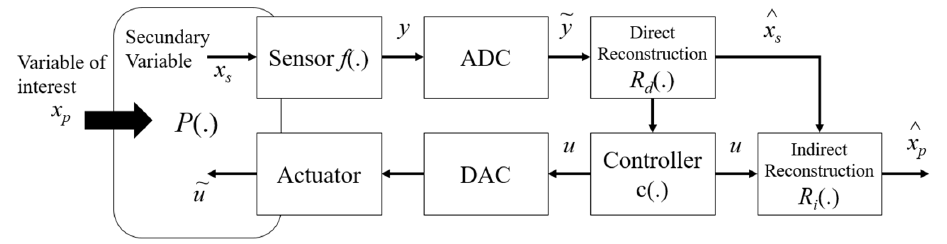
Figure 1. Generic diagram of a measurement feedback system adapted from [16]. Using sensors to acquire input variables, the secondary variable 𝑥 (cid:3046) is acquired and converted into an electrical signal 𝑦 using the sensor function 𝑓(cid:4666) . (cid:4667) . Then, this signal is converted to a digital signal through an AD inverter providing a signal 𝑦(cid:3556) , which is used to estimate the secondary quantity 𝑥 (cid:3046) , using the reconstruction function 𝑅 (cid:3031) . This last relationship corresponds to the inverse function of the sensor implemented in a discrete system. The signal 𝑥(cid:3548) (cid:3043) corresponds to the reconstruction of the signal coming from the input but indirectly from the controller 𝑐(cid:4666) . (cid:4667) and the direct reconstruction 𝑅 (cid:3031) (cid:4666) . (cid:4667) . Equation (1) describes the conversion factor to obtain the 𝑥 (cid:3046) signal [7]. 𝑥 (cid:3404) 𝑅 (cid:4666)𝑦(cid:4667) (cid:3404) 𝑓 (cid:2879)(cid:2869) (cid:4666)𝑦(cid:4667) (1) (cid:3046) (cid:3031) The DA inverter and the actuators present are responsible for controlling the secondary variable 𝑥 𝑠 at a certain reference value (setpoint). For this, the controller uses the measured values of the secondary variable together with the setpoint value, generating a discrete signal ( 𝑢 ) . This signal is converted into an analog signal (through a D/A inverter) and then through an actuator; this converted signal is applied to the 𝑃(cid:4666) . (cid:4667) plant. Thus, after these procedures, the main variable is estimated in the indirect reconstruction block 𝑅 (cid:3036) (cid:4666) . (cid:4667) , using the values of the control signal. Equation (2) represents this estimation. 𝑥 (cid:3043) (cid:3404) 𝑅 (cid:3036) (cid:4666)𝑥 (cid:3046) , 𝑢(cid:4667) (2) The actuation signal modifies the dynamics of the plant 𝑃(cid:4666) . (cid:4667) so that the response of the secondary signal 𝑥 𝑠 follows the setpoint value; therefore, it will modify the dynamics in the estimation of the main variable 𝑥 𝑝 . The convergence speed of this estimate will depend on how the controller is designed. 3.3. Adaptive Control In today’s language, the term adapt means to modify behavior according to new circumstances or situations. In the engineering context, adaptive control can be defined as a control technique that could change its behavior according to changes in parameters, in the dynamics of a process or by disturbances that affect this system [15]. Thus, a fixed gain controller (PID for example) is not an adaptive system. An adaptive controller must have the ability to update its control law by changing its gains (or parameters) in real time. In applications involving WSS, external parameters such as temperature, equipment wear and disturbances can alter the system’s operational dynamics. Thus, the use of controllers with static gains, in these scenarios, ends up not being convenient because they are tuned considering that the system is invariant in time and/or only for a specific operating range. Furthermore, the existence of noise and interference from different sources can directly influence the controller’s performance and, in the worst cases, lead to instability in the system [4]. To control these categories of system, controllers with adaptive gains stand out from those with static gains, as they could modify their parameters according to the changes suffered by the system [7,14].